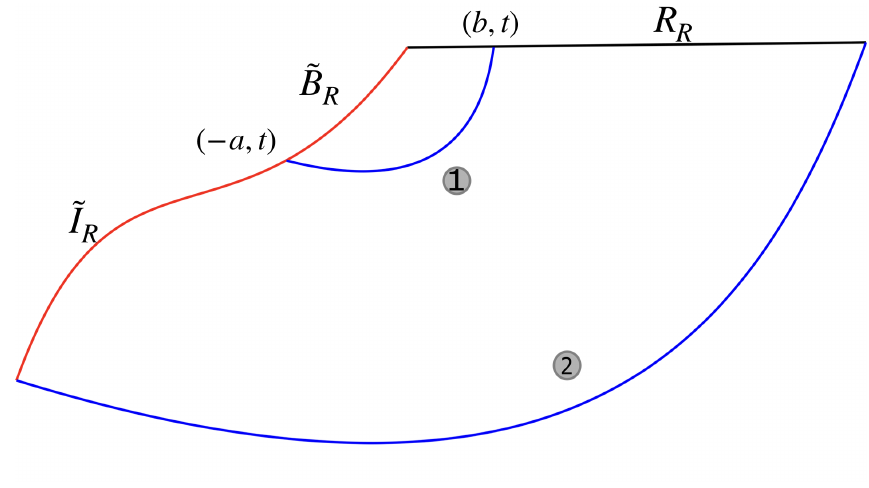
Figure 23: Schematic of island proposal-I for the entanglement negativity of the mixed state of the adjacent interval in the bath and the black